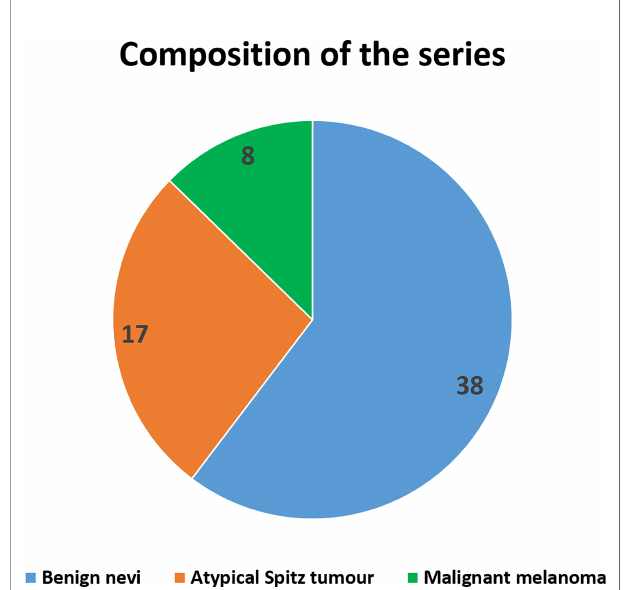
FIGURE 1 | Number of patients included in the study according to skin lesion type.